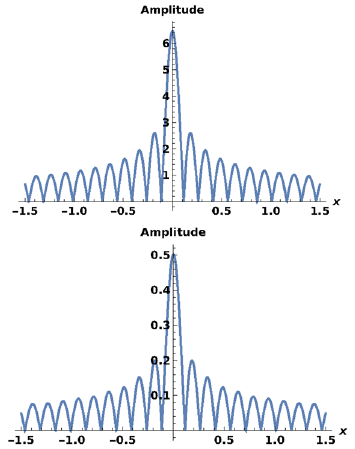
Figure 8. Transverse wave amplitude (arbitrary units) as a function of lateral distance from the center axis for the two cases shown in Figure 7. These are measured at 8 mm range from the transducer and are closely approximated by a Bessel function of zero order.